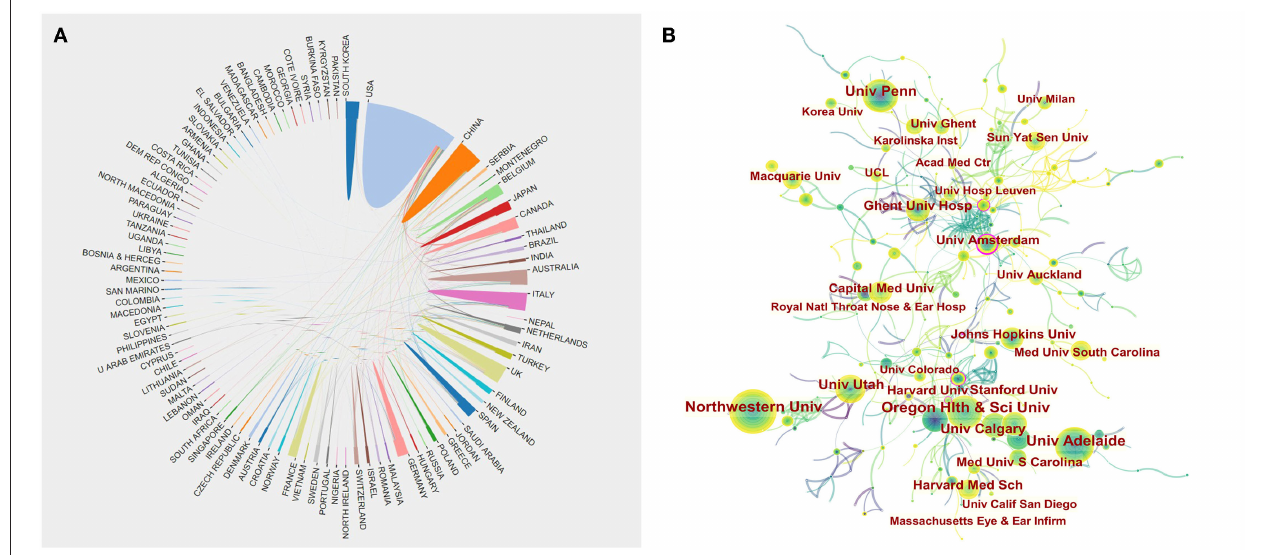
FIGURE 3 | Co-operation of countries/regions (A) and institutions (B) contributing to publications on CRS-treatment research from 2001 to 2020.